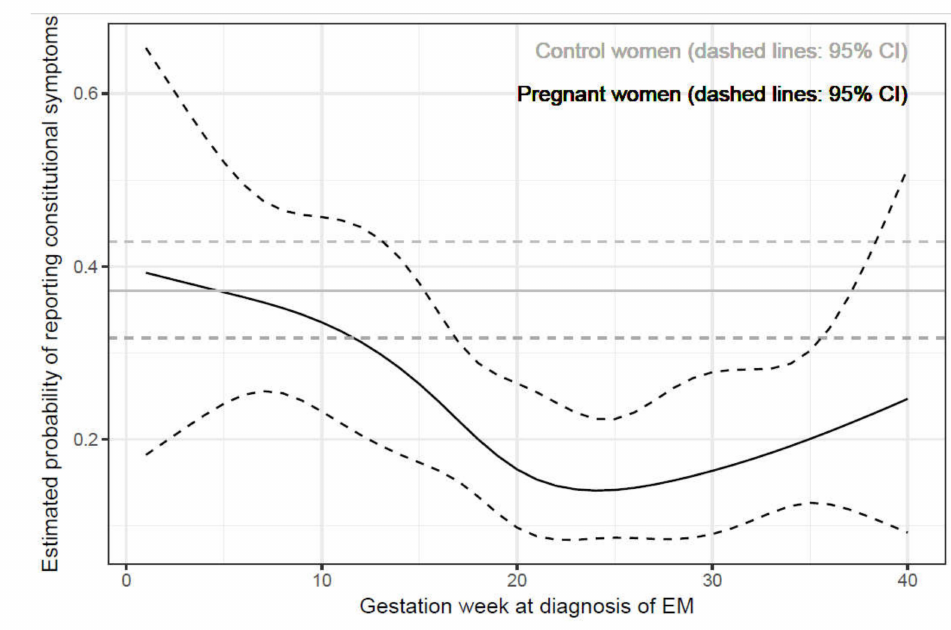
Figure 1. Estimated probability of reporting constitutional symptoms in pregnant and non-pregnant women with erythema migrans. EM, erythema